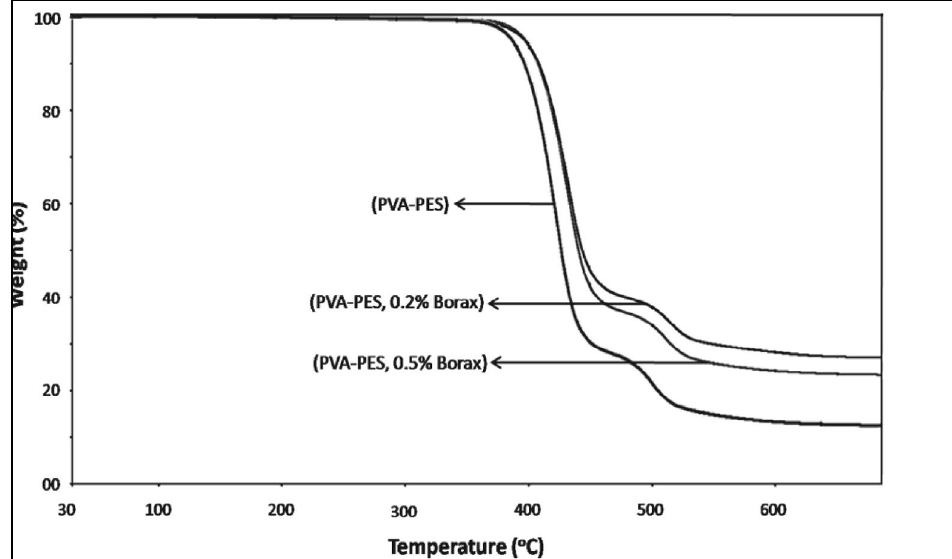
Fig. 3. TGA thermograms of PVA-PES composite membrane specimens cross linked with 0.2% and 0.5% borax as cross-linking agent used in the present study.